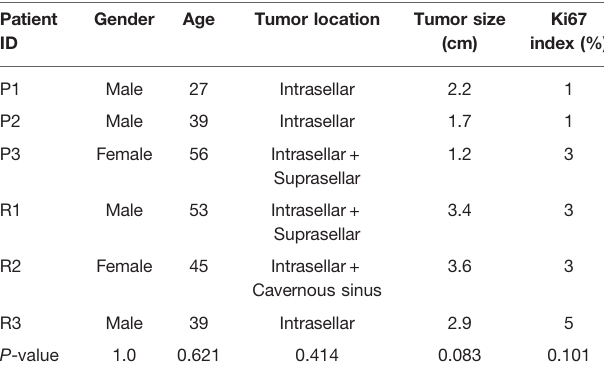
TABLE 1 | Clinical characteristics of patients whose tumor was detected by Transcriptome